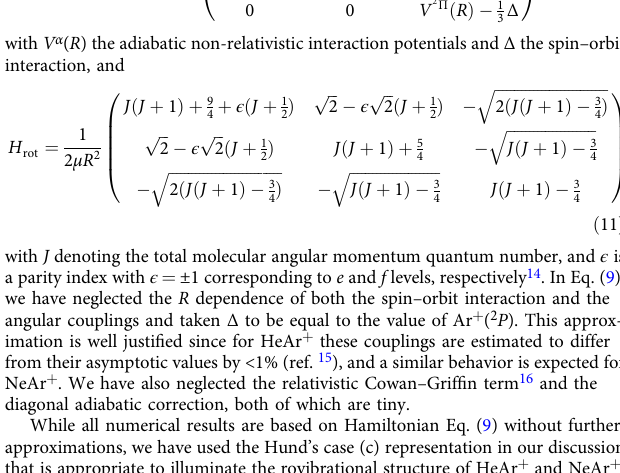
q ffiffiffiffiffiffiffiffiffiffiffiffiffiffiffiffiffiffiffiffiffiffiffiffiffiffiffiffiffi (cid:3) 2 ð J ð J þ 1 Þ (cid:3) 3